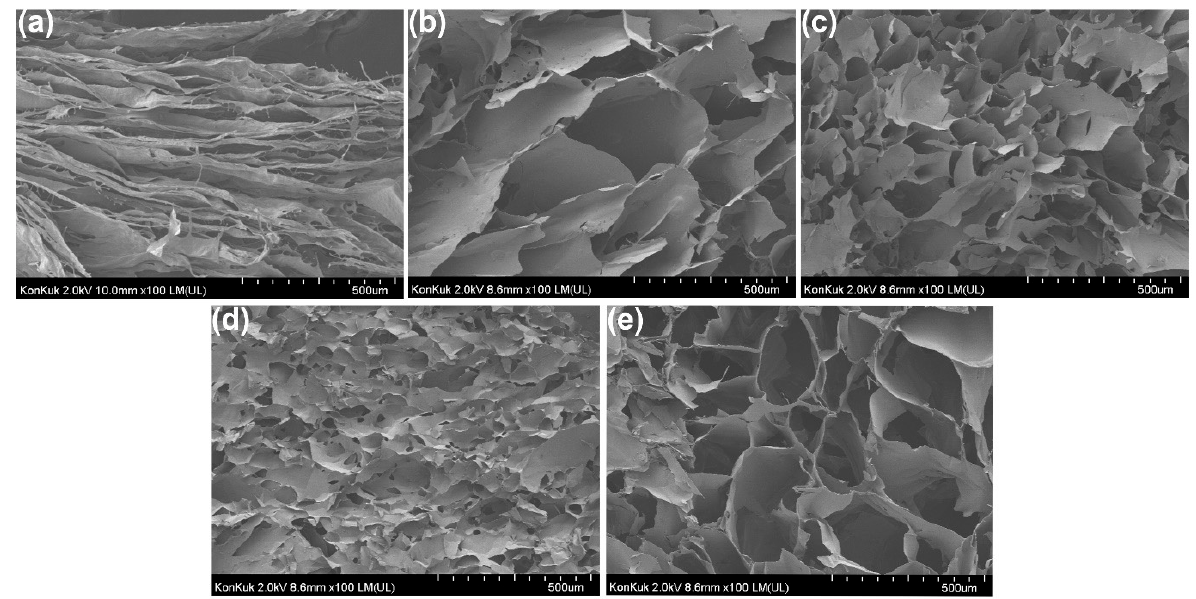
Figure 6. FE-SEM images illustrating the microstructures of cross-sectioned hydrogels: ( a ) Succinoglycan; ( b ) AG4/SG6; ( c ) AG6/SG4; ( d ) AG8/SG2; and ( e ) AG10.